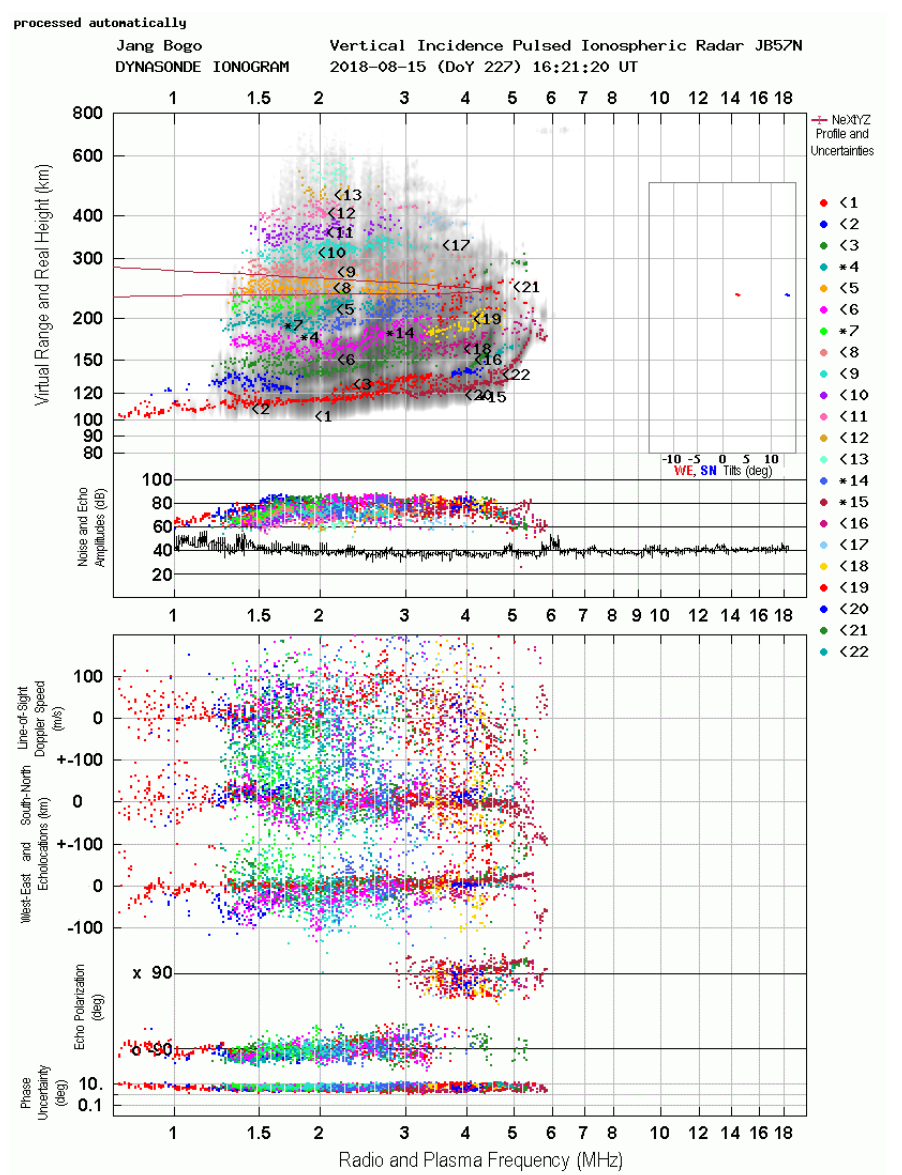
Figure 7. An ionogram and the resulting density profile obtained by autonomous Dynasonde analysis on 15 August 2018 (F10.7 = 70.6 sfu, Kp = 3).